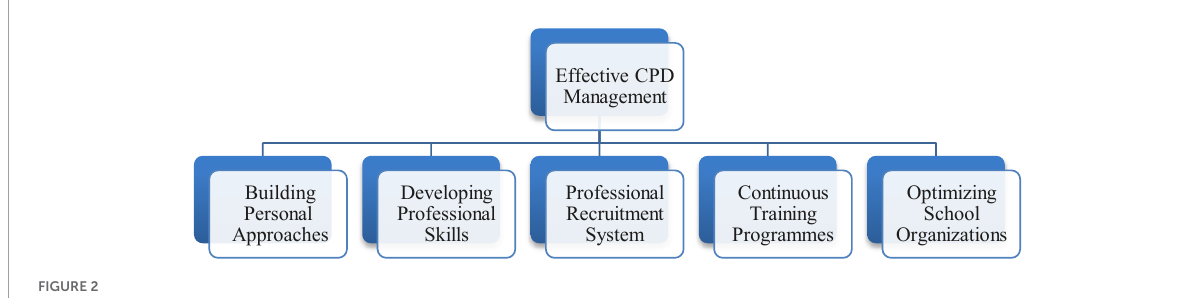
FIGURE2 Emerging themes from research question